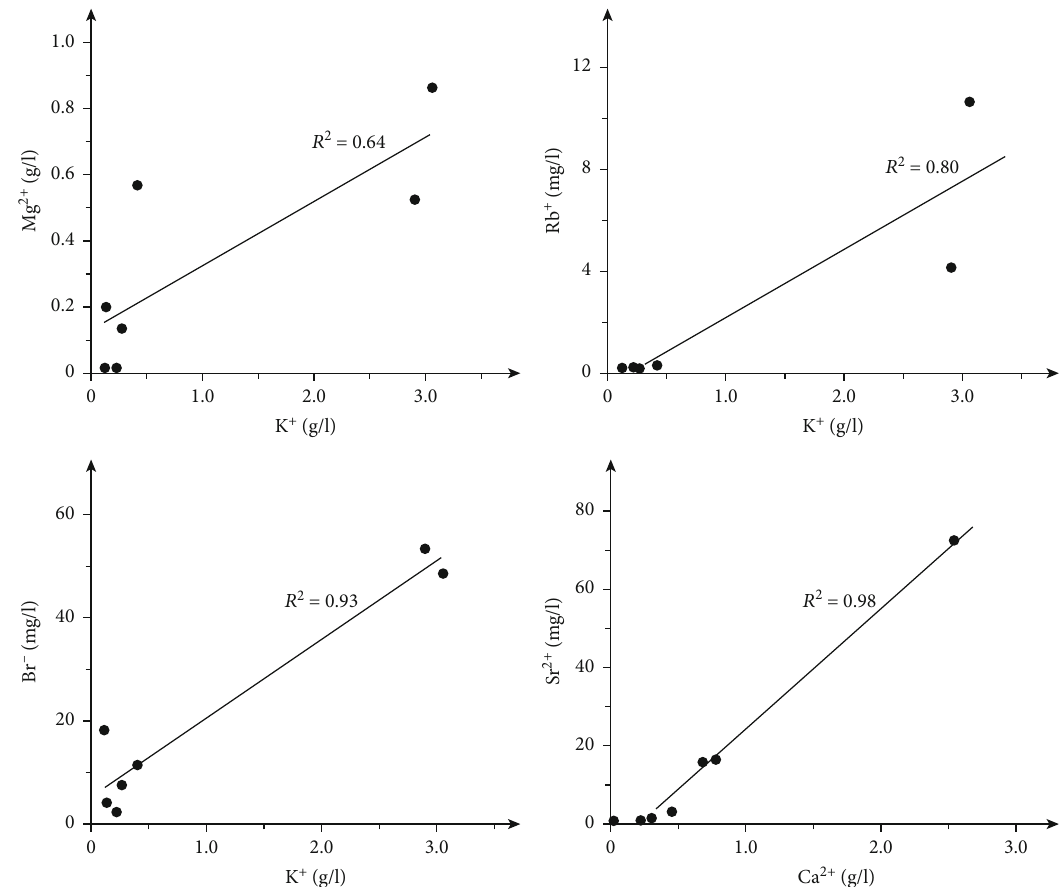
Figure 7: The relationships between K + and Mg 2+ , Rb + and Br - , and Sr 2+ and Ca 2+ in halite fl uid inclusions from 1476m in borehole